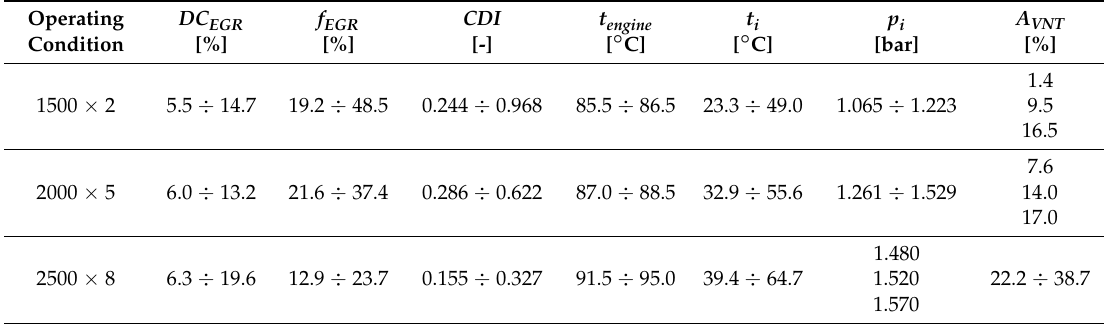
Table 5. Range of selected parameters in tests with simultaneous activation of EGR circuits